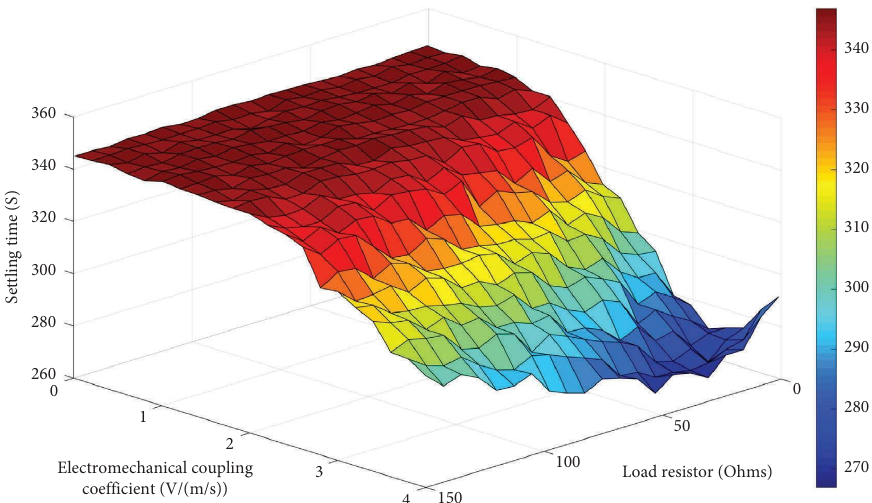
Figure 13: Settling time value for diferent values of C